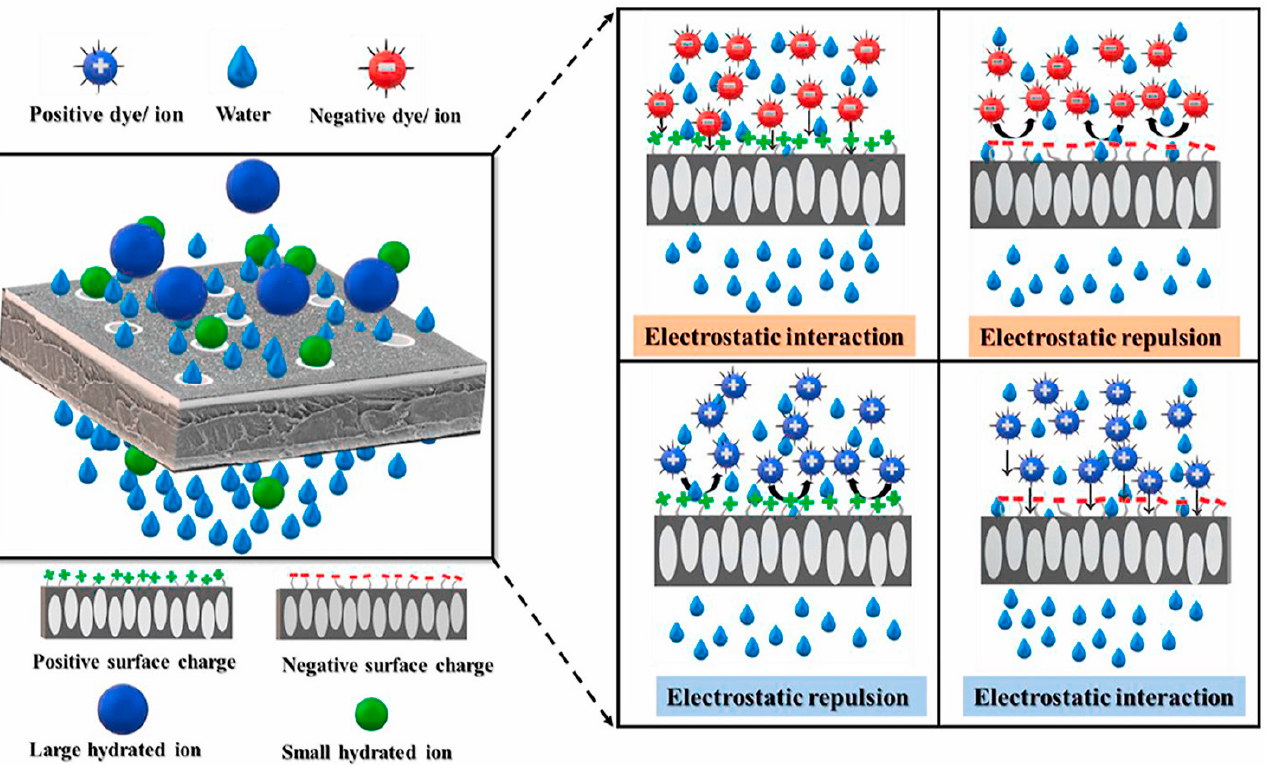
Figure 4. Schematic of dye removal with membrane process. (Source: [148]; copyright permission received on 15 February 2023, from Elsevier).